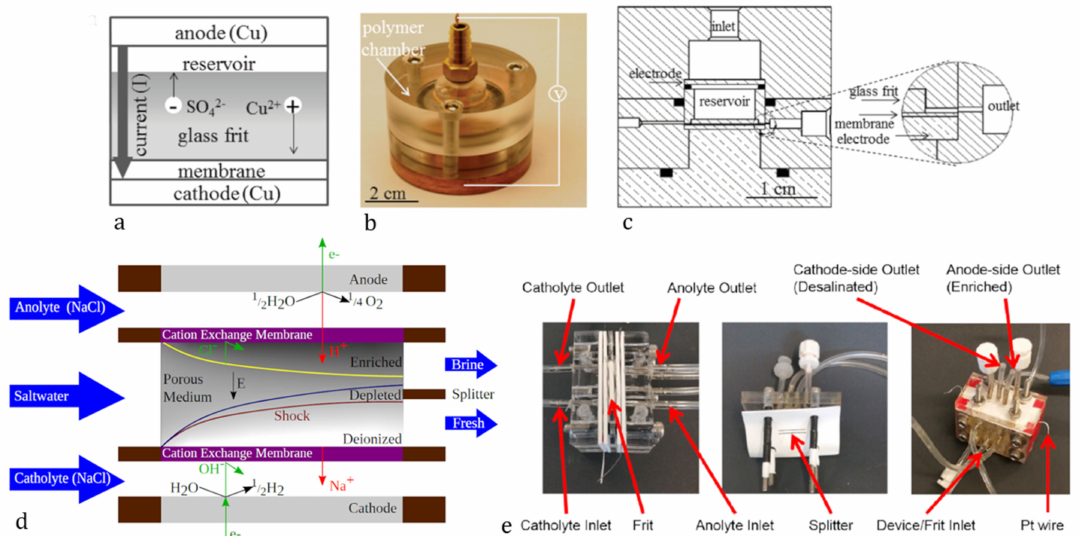
Figure 1. Shock electrodialysis device development. ( a ) shows the scheme of the “button” unit displayed on ( b,c ) [17]. ( d ) shows the operating principle of the “second generation” unit that is displayed in ( e ) and has overall dimensions “2 × 2 × 1.5” [20]. Deionization shocks spread through the channels of the porous medium as a sharp concentration gradient. From these extended zones, freshwater and brine are separately collected. The outlet points are separated by a splitter, a thin partition that prevents the outlet streams from mixing once discharged from the device [20].